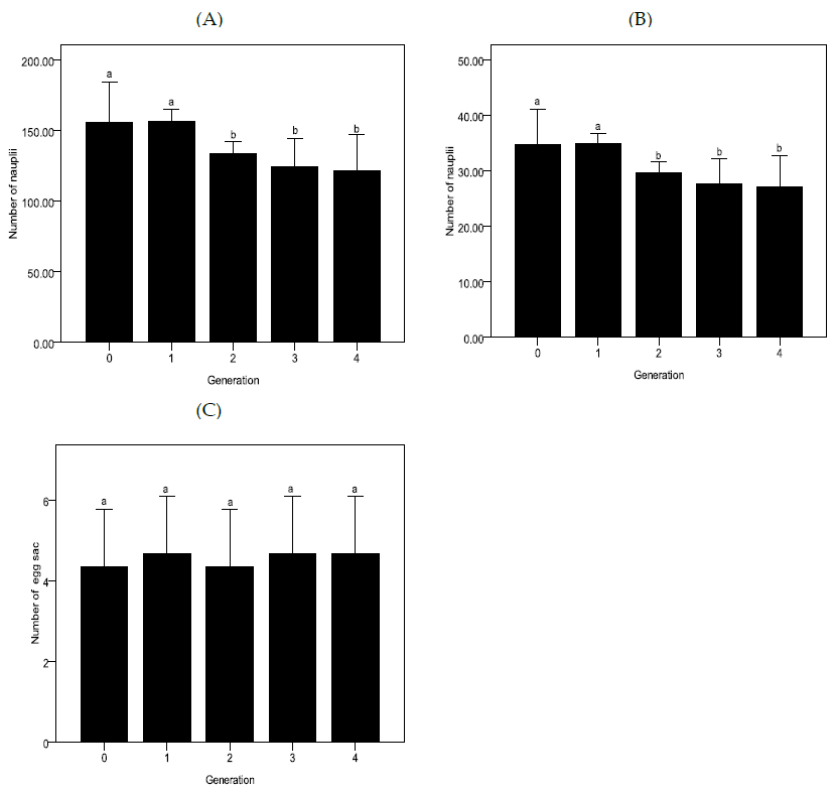
Figure 5. Effect of seawater acidification on the fecundity (mean ± standard deviation, n = 6) of T. japonicus in five generations. Successive generations were exposed to a lower pH than their parents. ( A ) The total number of nauplii produced in 10 days, ( B ) the average number of nauplii per egg sac, and ( C ) the number of egg sacs. Statistical differences among generations ( p < 0.05) are represented by different letters.